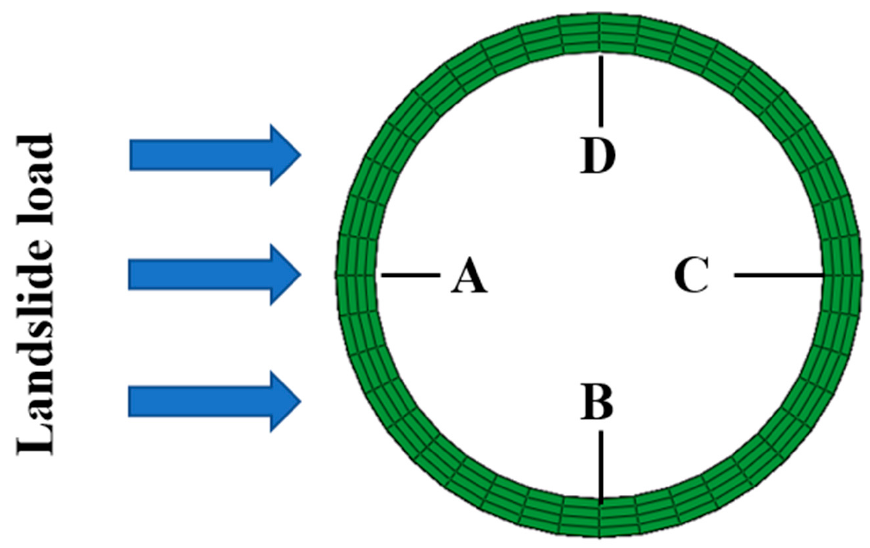
Figure 10. Points A, B, C and D on the symmetric surface of the SWW-RTP model.